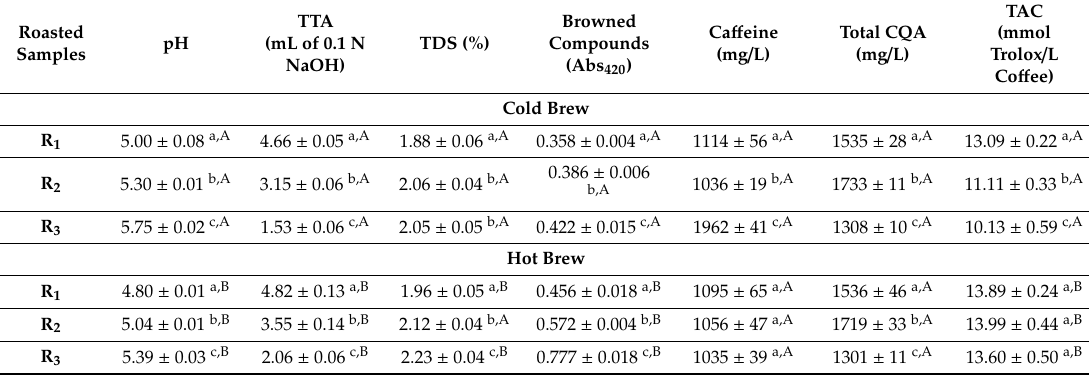
Table 1. Physicochemical characteristics of cold and hot brew co ff ee samples at three di ff erent degrees of roast. TTA: total titratable acids to a pH 6.5 expressed in ml of 0.1 N NaOH per 40 mL of co ff ee, TDS: total dissolved solids, TAC: total antioxidant capacity determined by the ABTS decolorization assay expressed in mmol of Trolox per liter of co ff